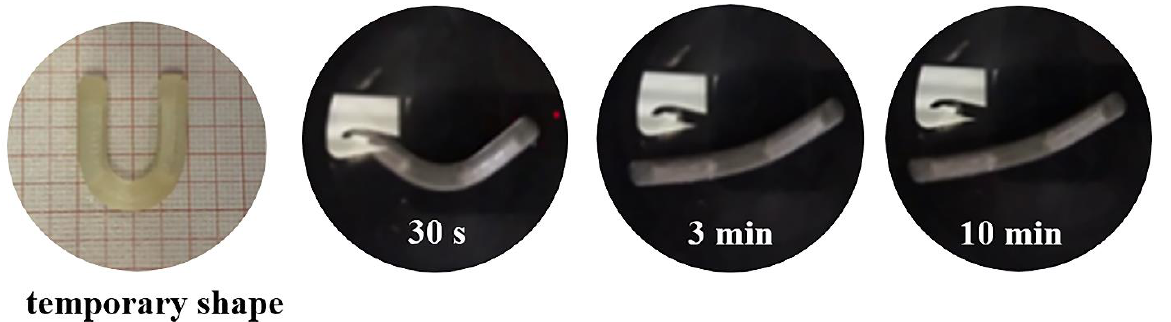
Figure 9. Photographs of an I sample, printed with 100% infill and filled with the drug tracer, after programming of the temporary U shape and during the recovery experiments.